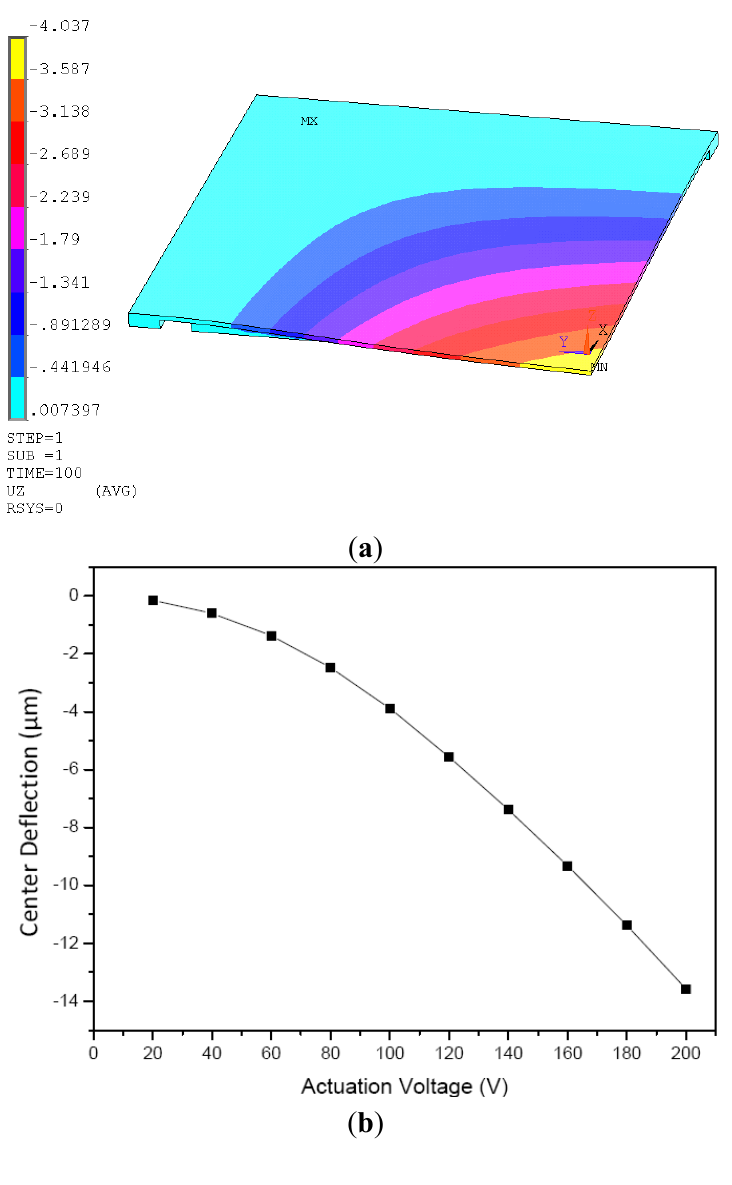
Figure 4. BCB cap deflection simulation results. ( a ) BCB cap deflection when